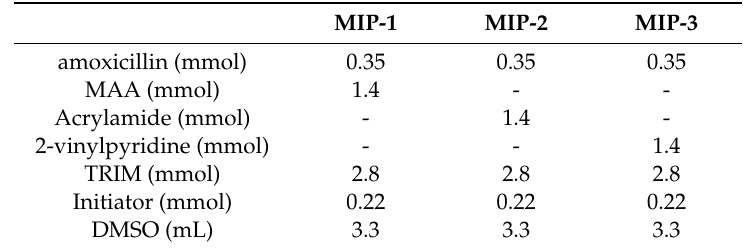
Table 1. The composition of the di ff erent Molecularly Imprinted Polymers (MIPs), listing the amount of template, functional monomer, crosslinker monomers, initiator and porogen